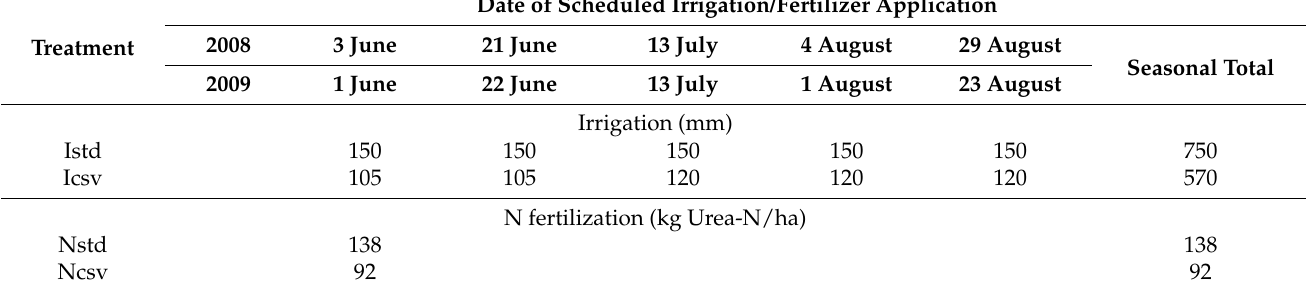
Table 3. Irrigation and fertilizer schemes of spring maize. Date of Scheduled Irrigation/Fertilizer Treatment